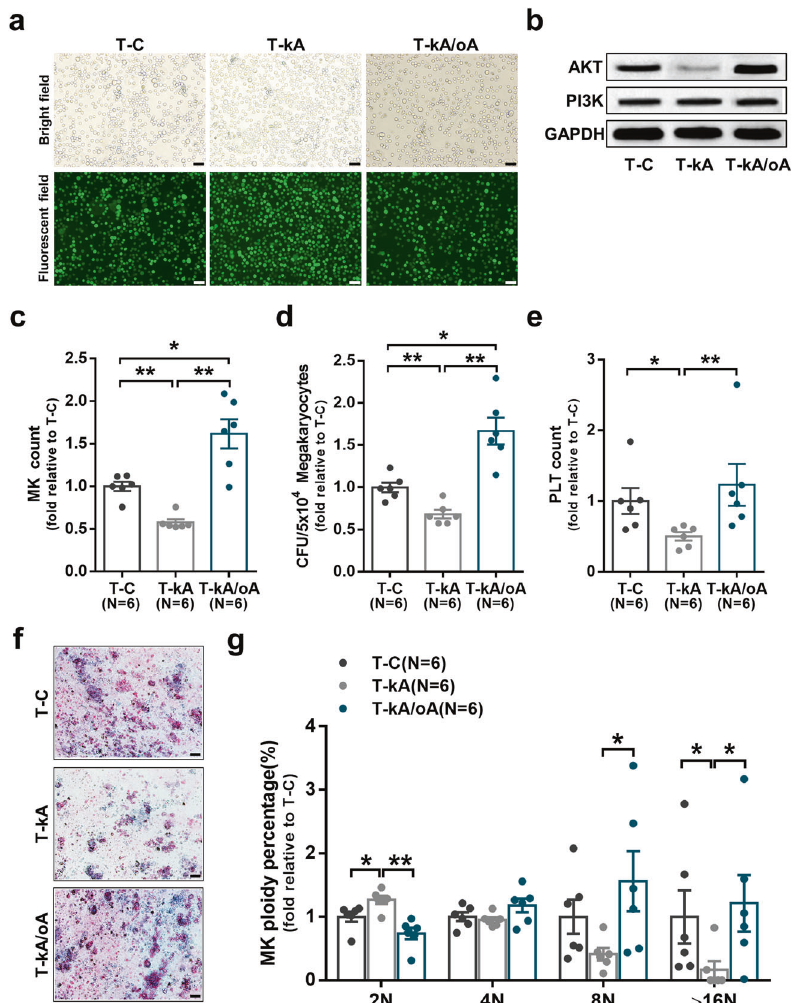
Fig. 5 The megakaryopoiesis-supporting ability of macrophages was improved by activating the PI3K-AKT pathway. a Representative fl uorescence microscopy images of THP1-derived M Ф s infected with lentivirus (scale bars represent 50 μ m). b Representative western blots of AKT, PI3K and GAPDH in THP1-derived M Ф s infected with lentivirus. MK production and maturation, CFU-MK plating ef fi ciencies, and platelet release were analyzed after coculture with the infected M Ф s. The c MK count, d CFU-MK count, e platelet count, f representative CFU-MK images (scale bars represent 50 μ m), and g MK ploidy distribution were analyzed after 12 days of coculture. Data are presented as the means ± SEM (* P ≤ 0.05, ** P ≤